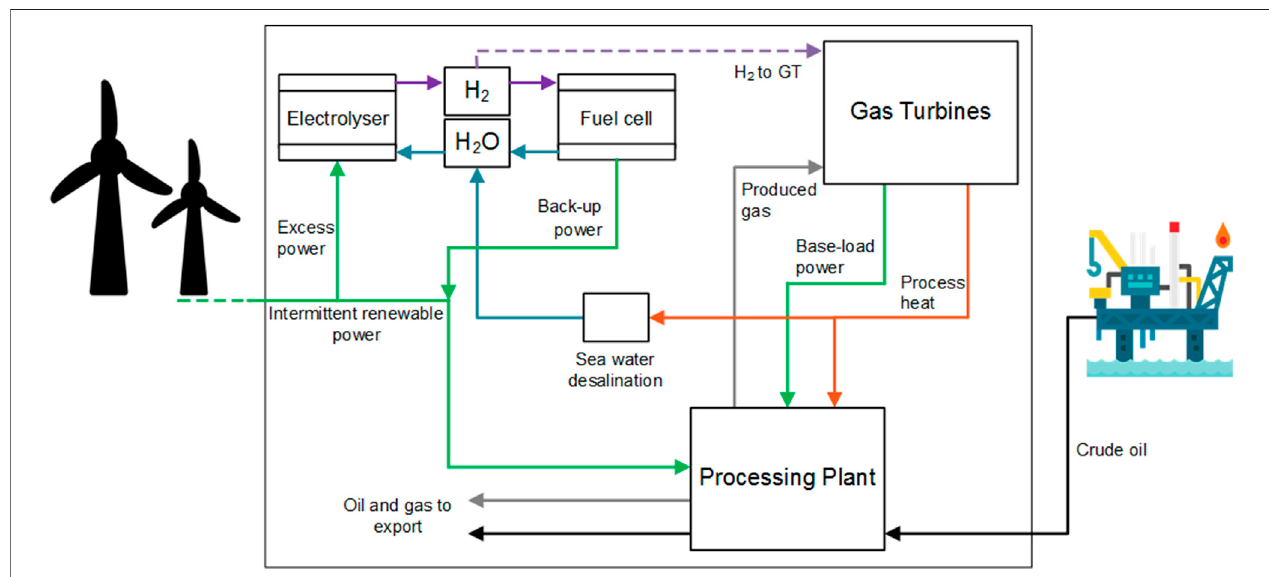
FIGURE 1 | Schematic representation of the proposed